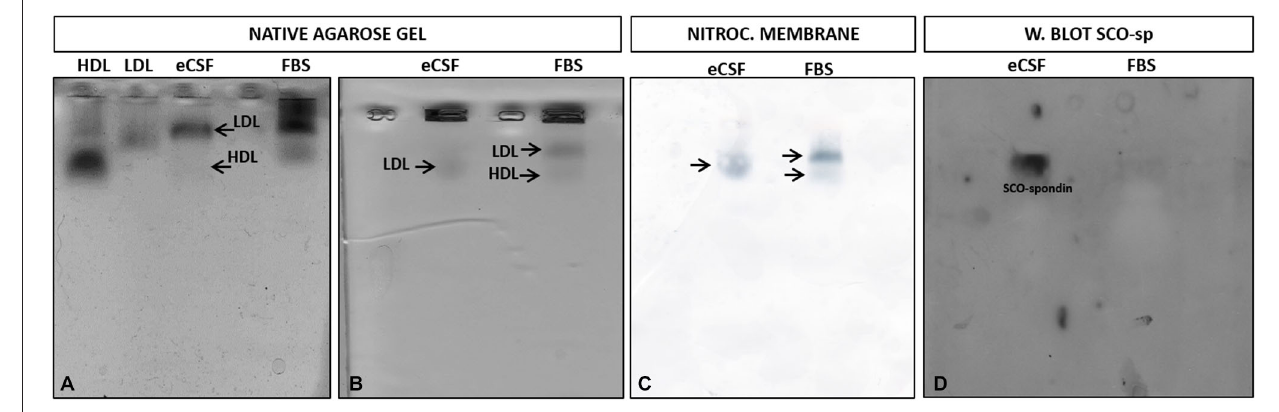
present in the eCSF. (B) Native agarose gel electrophoresis stained with Sudan black (lipid stain), revealing the presence of lipoproteins (arrows) in the eCSF and fetal bovine serum (FBS; control). (C) Transference of the gel shown in (B) to nitrocellulose membrane. (D) Western blot with anti-SCO-spondin of the nitrocellulose membrane shown in (C) , revealing a migration pattern of SCO-spondin identical to the eCSF LDL stained with Sudan black (B,C) .